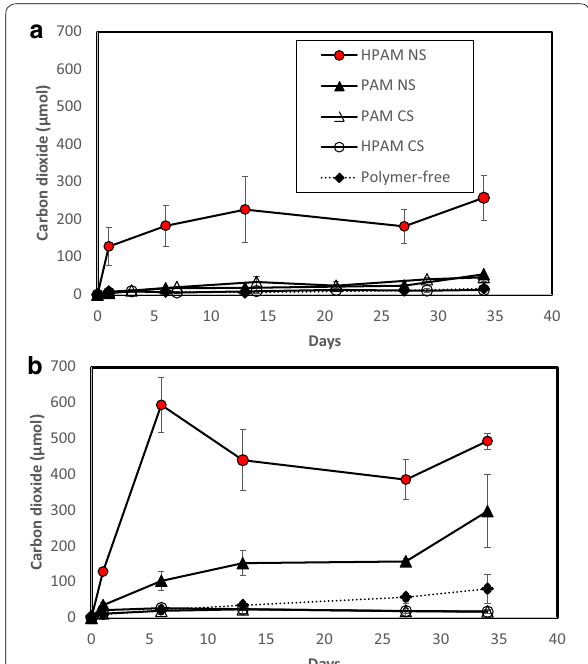
Fig. 2 Carbon dioxide levels over time in microbial cultures obtained from a PW and b sludge enrichments after 34 days of incubation at 50 °C. HPAM/PAM NS: polymers were added as N source (glucose was the C source). HPAM/PAM CS: polymers were added as a sole C source (sodium nitrate was the N source). Error bars indicate standard deviations of triplicate